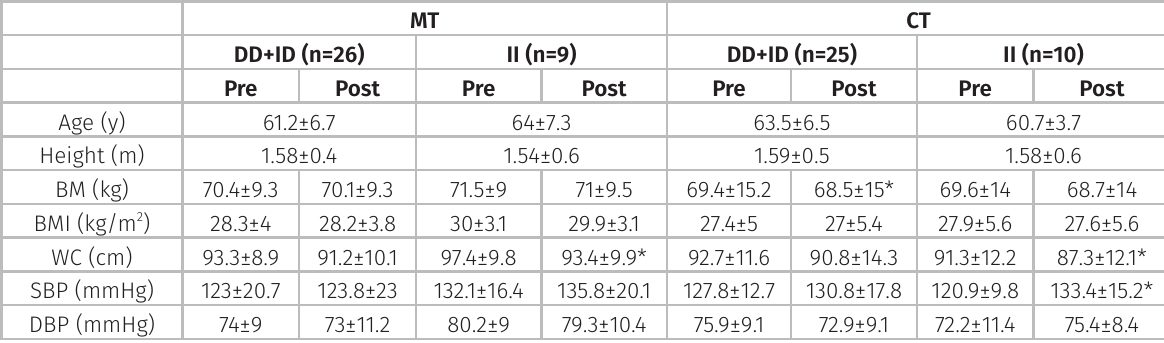
Data are presented as mean ± standard deviation (three-way repeated measured ANOVA followed by the post-hoc Tukey’s test). BM body mass, BMI body mass index, WC waist circumference, SBP systolic blood pressure, DBP diastolic blood pressure, MT multicomponent training, CT combined training. *p <0.05 intragroup